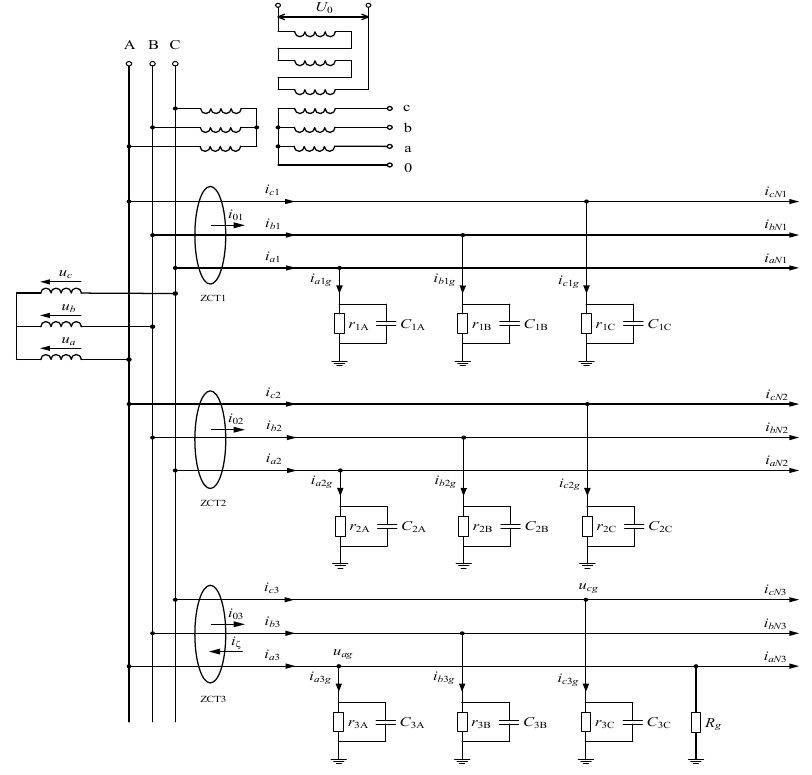
Figure 4. Single-phase earth leakage thumbnail Figure in a no-grounding system and its sampling